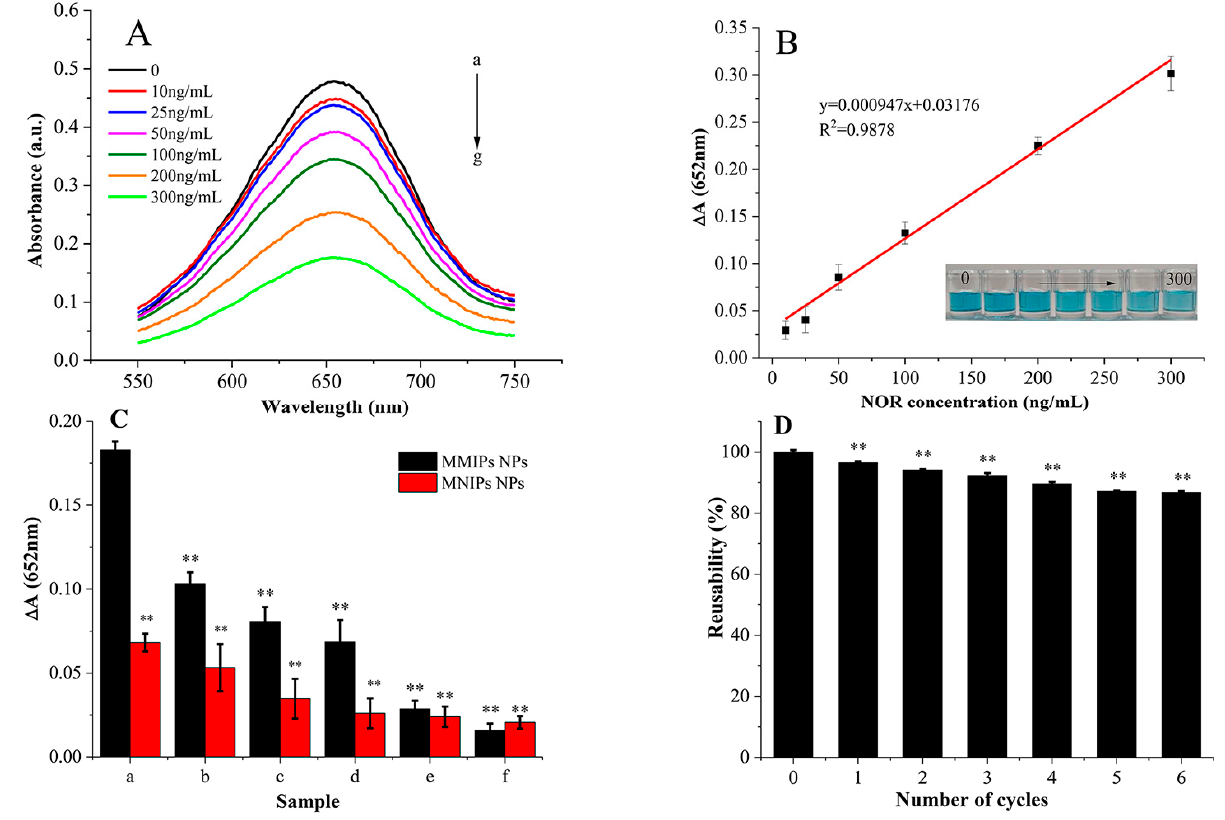
Figure 3. In situ colorimetric measurements. ( A ) Absorption spectra of oxTMB at different NOR concentrations (a–g: 0, 10, 25, 50, 100, 200, and 300 ng/mL). ( B ) Linear relationship between the Δ A (652 nm) and NOR concentrations. ( C ) The selectivity of the colorimetric chemosensor at 25 °C (a: NOR, b: CIP, c: ENR, d: DAN, e: SD, f: TC, with the initial concentration of 0.02 mg/mL), ** signifi- cantly different compared with MMIP NPs to NOR, p < 0.01. ( D ) The reusability of the Fe 3 O 4 MMIP NPs for NOR, ** significantly different compared to the first time used, p < 0.01. All trials were repeated 3 times.